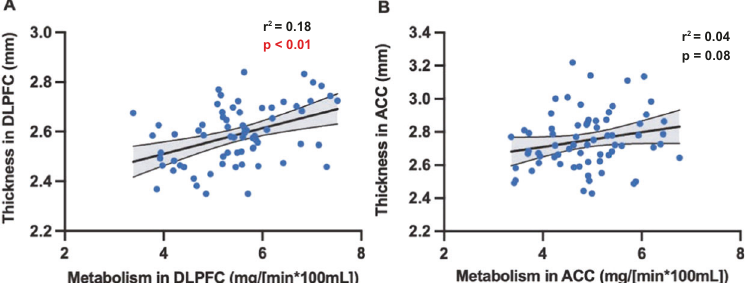
Fig. 2 Scatterplots of regional thickness in the cortical regions versus metabolism. The regression line represents the line of best fi t. The lines surrounding the gray shaded area represent the 95% con fi dence interval. DLPFC dorsolateral prefrontal cortex ( A ), ACC anterior cingulate cortex ( B